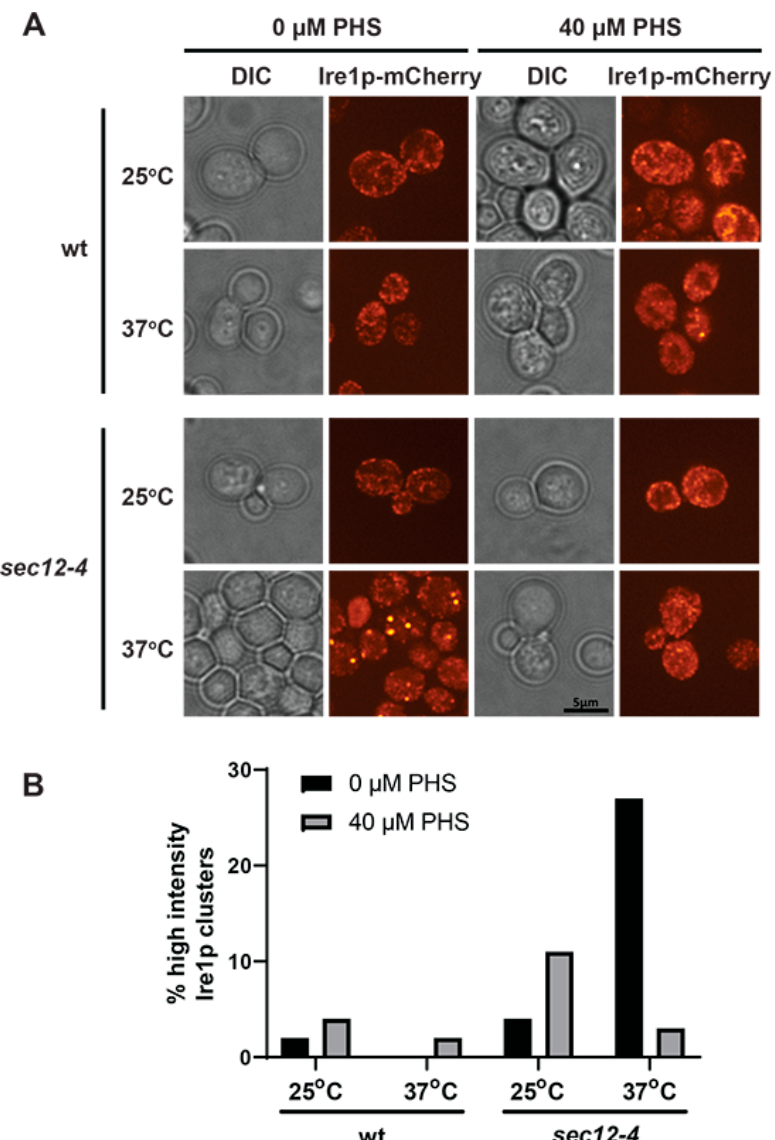
Figure 4. ER transport-derived Ire1 clustering is inhibited by phytosphingosine. ( A ) Fluorescence microscopy images of wt (CTY182) and sec12-4 ts (CTY252) cells expressing Ire1-mCherry. Cells were cultured at 25 °C with 40 μ M PHS 4 h, followed by shifting cultures to either 25 °C or 37 °C for 2 h. ( B ) Cell counts determining the proportions of cells containing high-intensity Ire1–mCherry clusters (taken from microscopy images described above). At least 150 cells were counted for each condition.